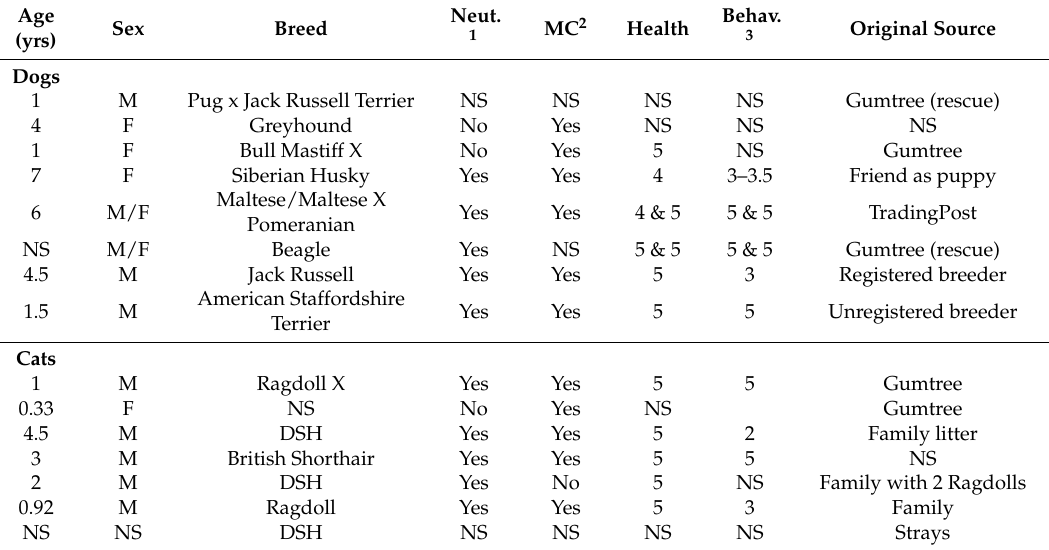
Table 7. Demographic factors for the dogs and cats being relinquished by the 16 people